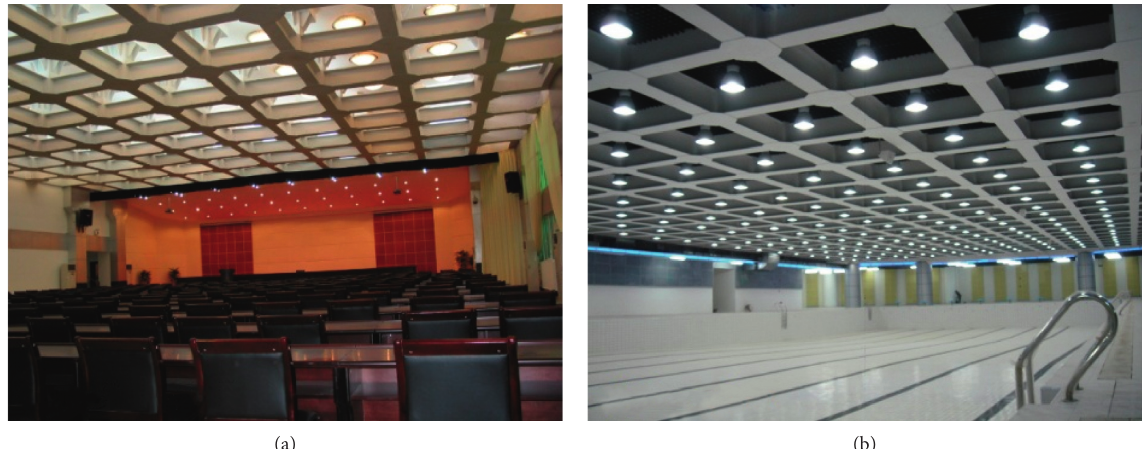
Figure 1: Applications of COF in practical projects. (a) Conference hall. (b) Natatorium.